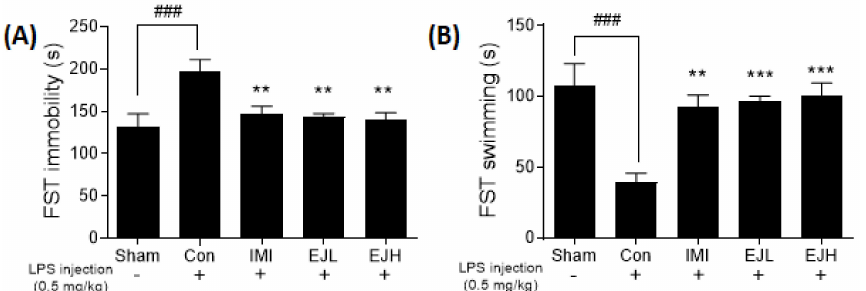
Figure 6. E ff ect of EJE on the forced swim test in LPS-induced depressive mice. LPS-injected mice showed significantly increased immobility and decreased swimming, while EJ extract-treated mice showed significant improvements, with a reduced immobility time (s) ( A ) and increased swimming time (s) ( B ). Results are presented as mean ± SEM. FST, forced swim test; EJE, E. japonicum extract; LPS, lipopolysaccharide; Con, control; IMI, imipramine 30 mg / kg; EJL, EJE 100 mg / kg; EJH, EJE 300 mg / kg. *** p < 0.001, ** p < 0.01, versus the LPS-injected Con; ### p < 0.001 versus the